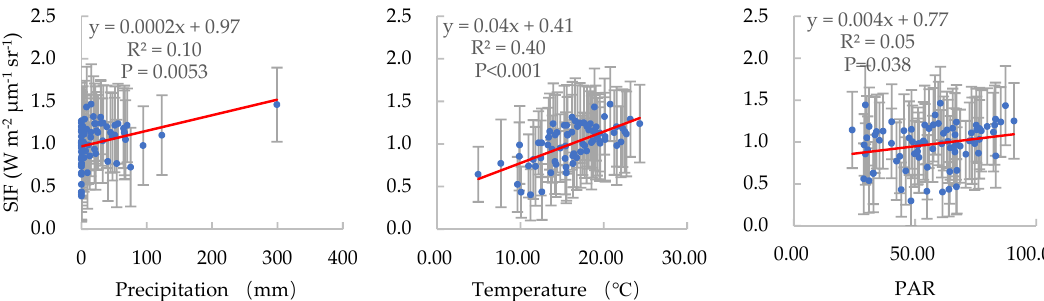
Figure 8. Scatter plot between SIF and precipitation (left), temperature (middle), and PAR (right) at a daily scale.